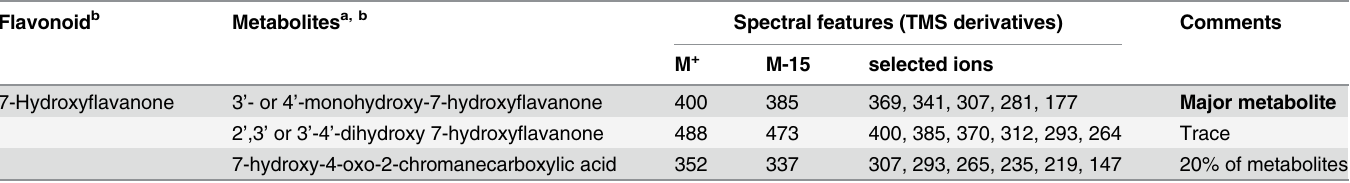
Table 5. Metabolites produced by strain U23A during co-metabolic growth on 7-hydroxyflavanone. Flavonoid b